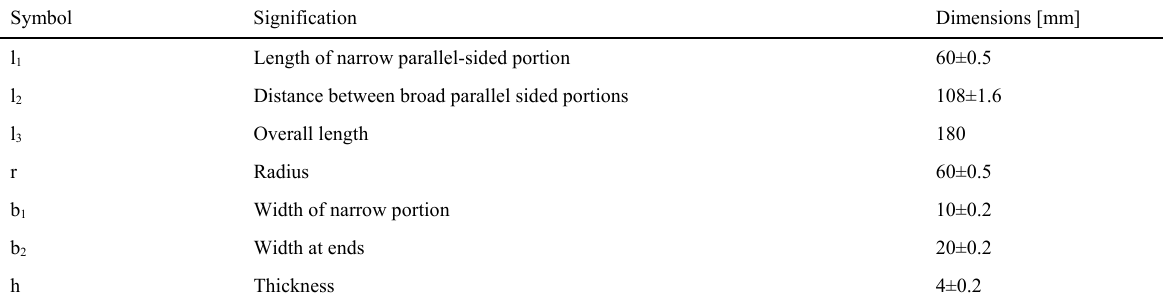
Table 1: Dimensions of a dog bone sample (Type 1B) according to NBN EN ISO 527-2 (NBN